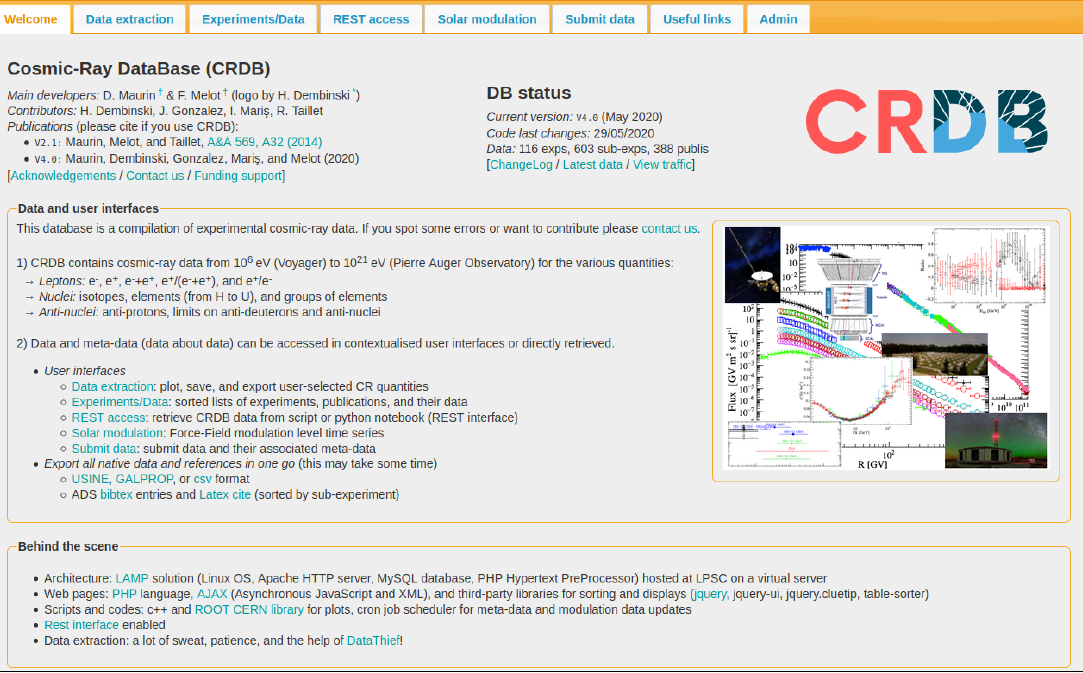
Figure 4. Snapshot of the ‘Welcome’ tab to which users are directed from the CRDB webpage https: //lpsc.in2p3.fr/crdb. Clicking on the tabs (shown on top) allows to access the various user-interfaces presenting in different ways the contextualised data and meta-data (see